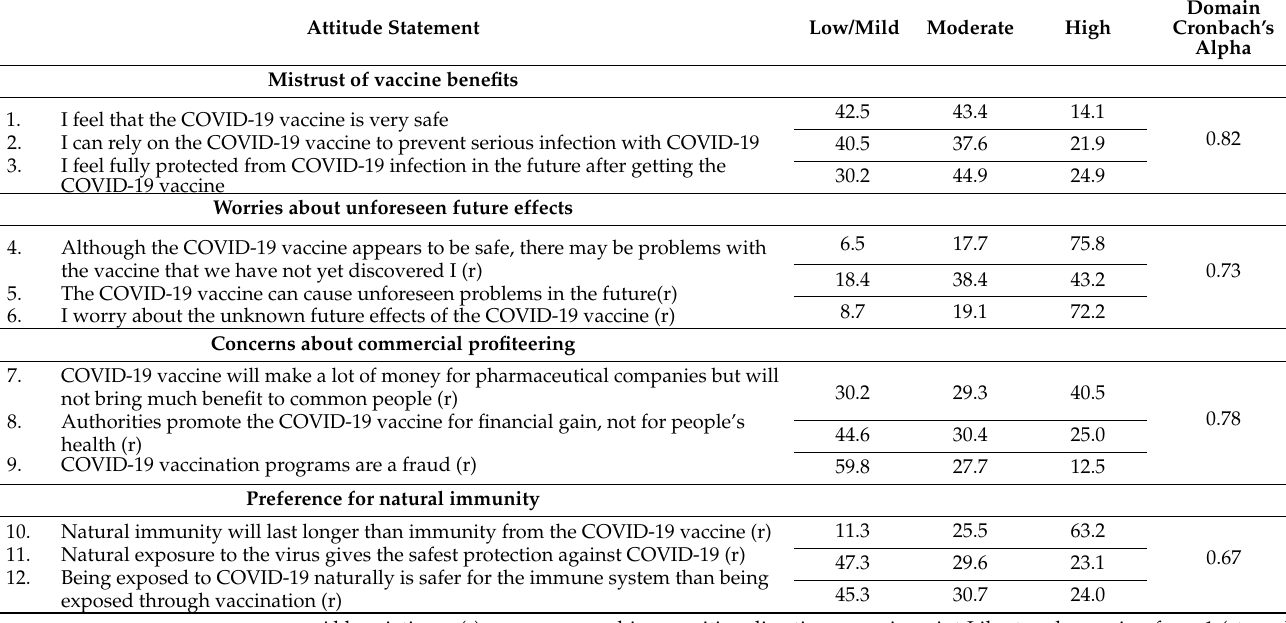
Table 2. Summary of COVID-19 attitude statements and vaccine hesitancy levels (in percentages,